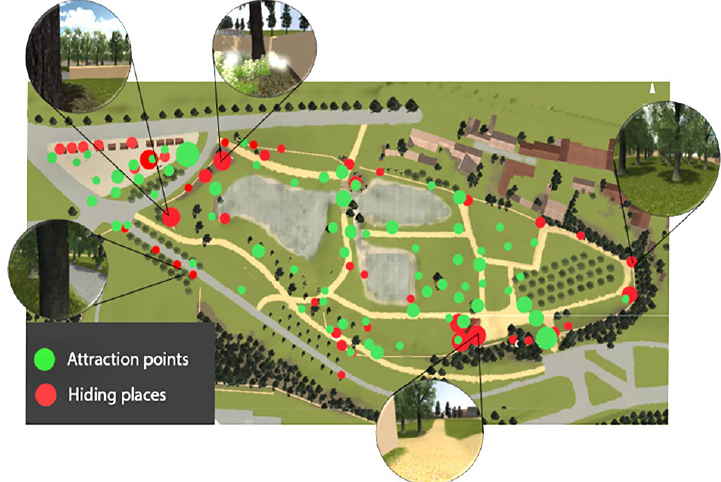
Figure 9. Concentration points of the hiding places and the attraction places of the virtual urban park “Missionary Garden”. The size of the markers corresponds to the amount of the points detected in the neighbourhood